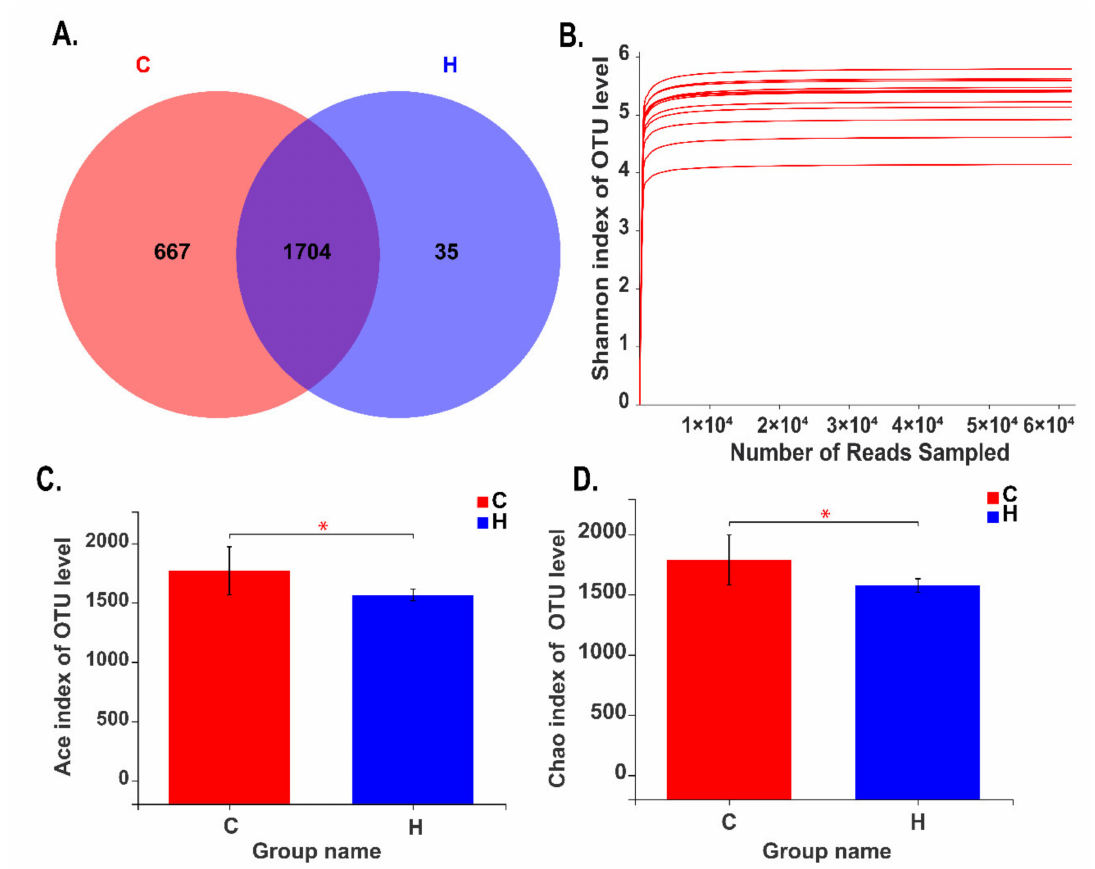
Figure 1. 16S rRNA gene sequences in di ff erent dietary groups. A Venn diagram illustrating the overlap of bacterial OTUs at a 3% dissimilarity level for Groups C and H. ( A ). The samples of Group C included the goats fed with a typical total mixed ration (TMR), and the samples of Group H included the goats fed with the high energy and high protein diets. Rarefaction analysis of di ff erent samples ( B ). Di ff erences in ACE indices ( C ) and Chao indices ( D ) between Groups C and